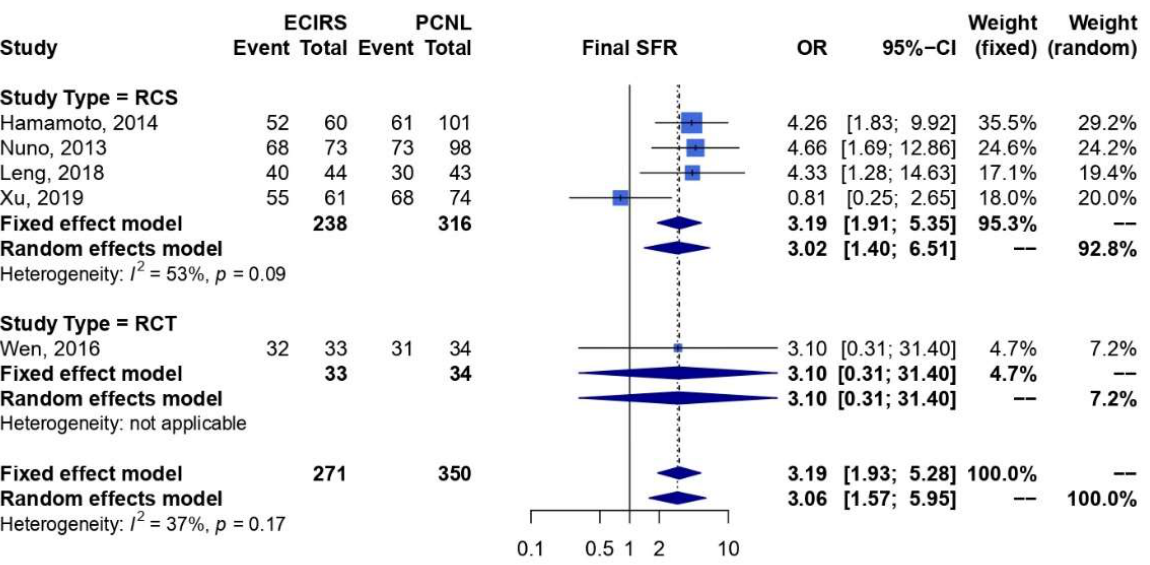
Figure A11. Subgroup analysis of outcome regarding final stone free rate. (RCS: [18-23]; RCT: [17])